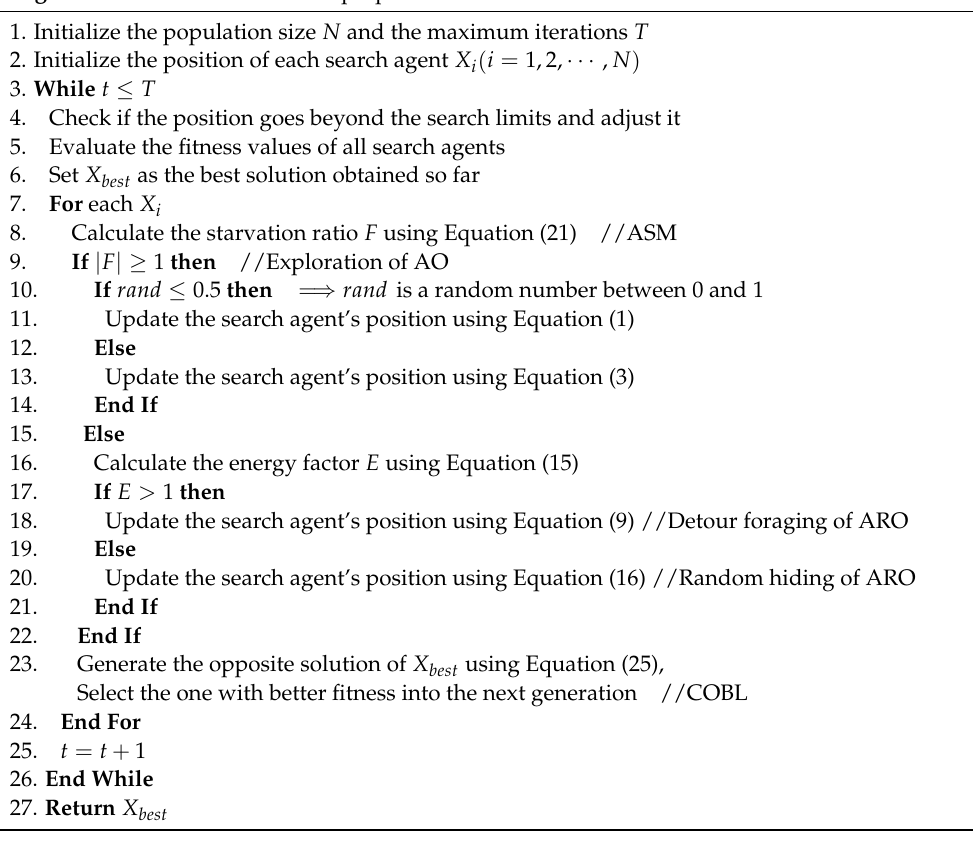
Algorithm 1. Pseudo-code of the proposed